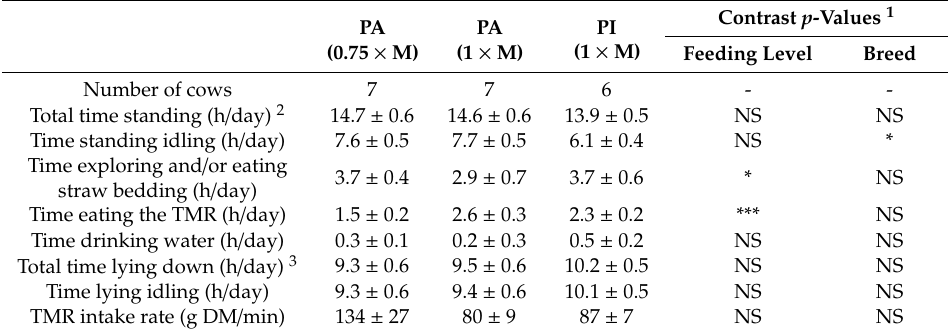
Table 3. Daily activity budget and intake rate in indoor-housed lactating beef cows fed on TMR.